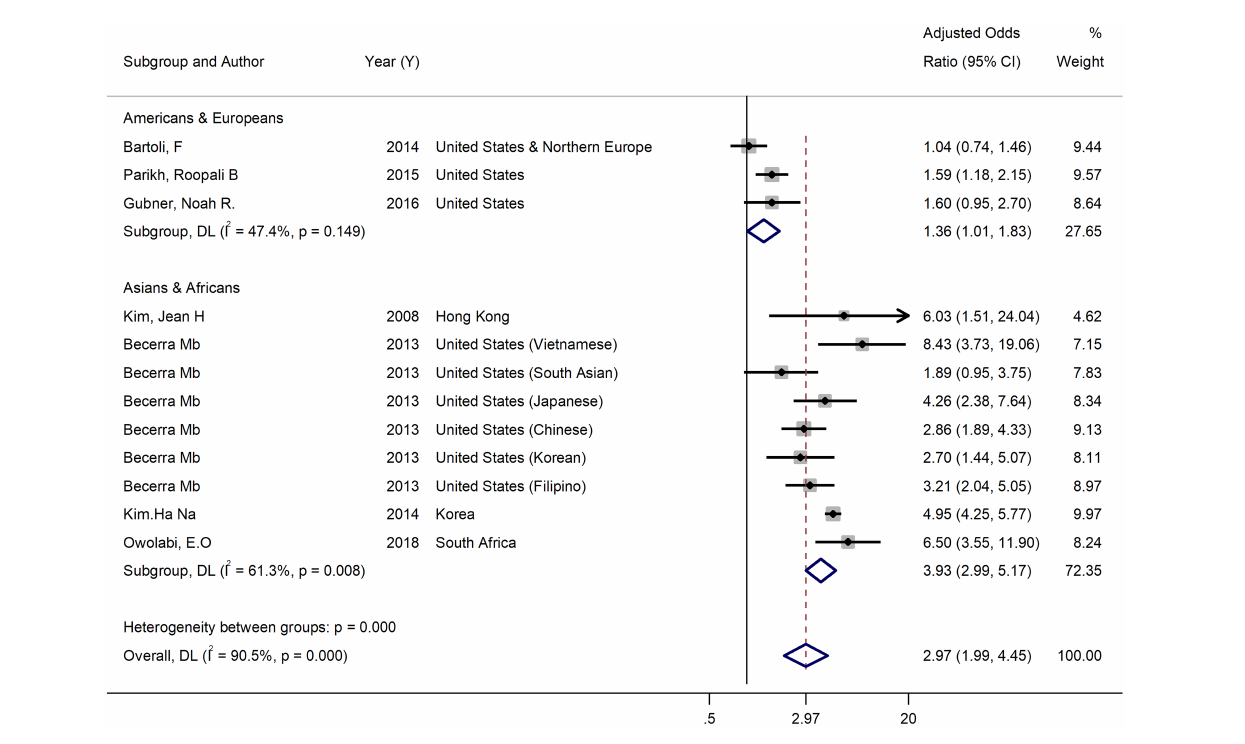
FIGURE4 Forest plot of the association between binge drinking and current smoking by nationality. Weights and between-subgroup heterogeneity test are from random-effects model.